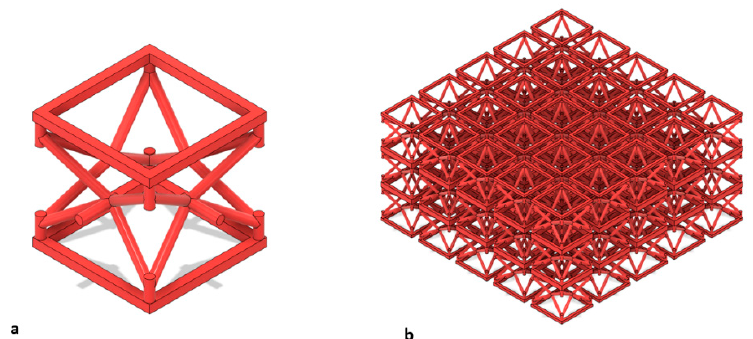
Figure 4. A three-dimensional CAD model for the meta-functional auxetic unit cell model ( a ) and composite bridge bearing model ( b ), respectively.